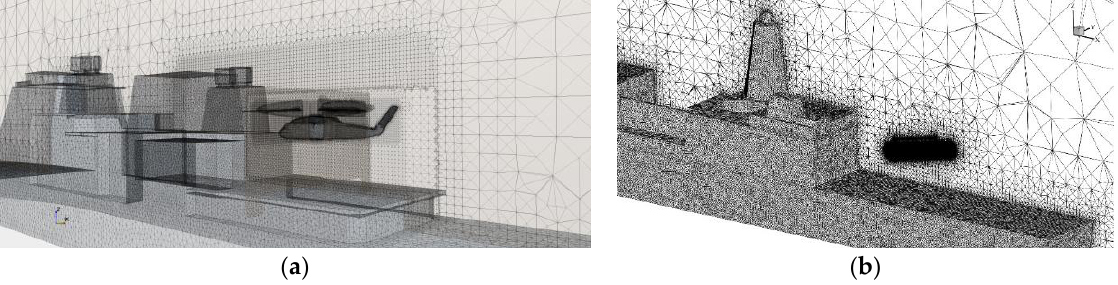
Figure 3. Refined mesh near the ship and above the flight deck. ( a ) CG47 and UH60; ( b ) LPD17 and SA365.